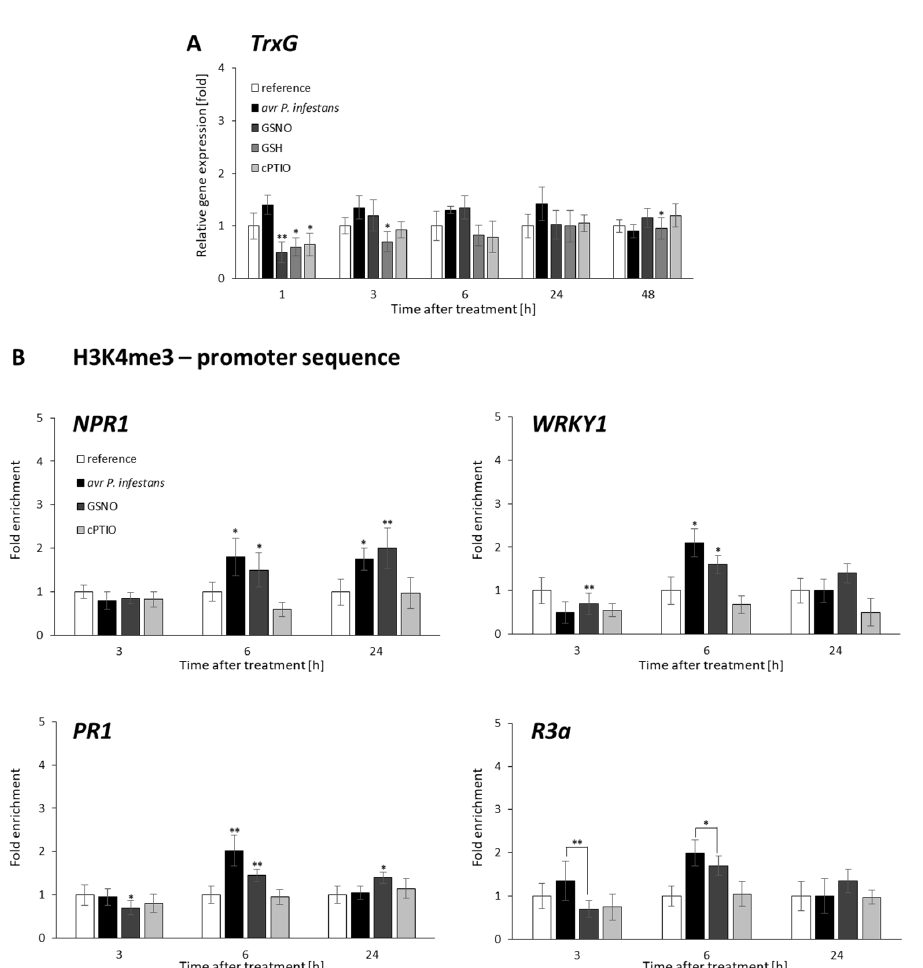
Figure 4. TrxG methyltransferase expression profile ( A ) and distribution levels of H3K4me3 on the promoters of NPR1 , WRKY1 , PR1, and R3a , respectively ( B ). RT ‐ qPCR gene expression of CLF was promoters of NPR1 , WRKY1 , PR1 , and R3a , respectively ( B ). RT-qPCR gene expression of CLF